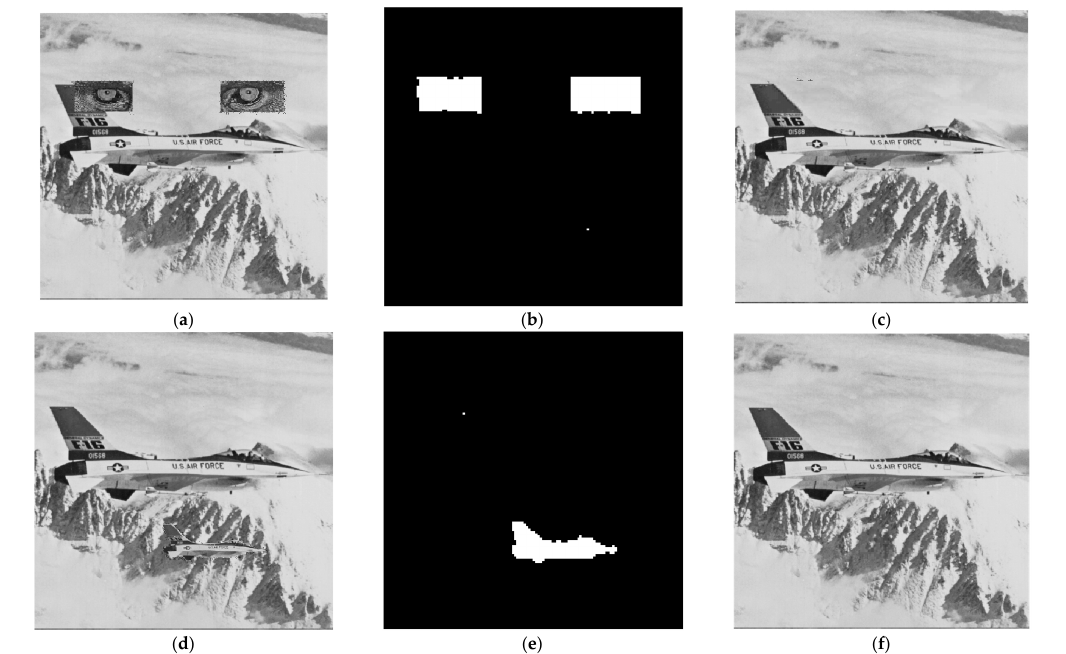
Figure 12. The visual performance for Barbara: ( a ) Cutting attack 1, ( b ) Detection of ( a ), ( c ) Recovery of ( a ), ( d ) Cutting attack 2, ( e ) Detection of ( d ), and ( f ) Recovery of ( d ). We further simulated two kinds of copy-paste attacks to measure the detection and recovery performance. The copy-paste attack copies the image blocks from one authenti- cated image and then inserts them into arbitrary positions in the watermarked image. Fig- ures 13 and 14 show the visual performance under copy-paste attacks for Airplane and Barbara, respectively. The tampering rates α are set to be 4.53% and 1.84% for copy-paste attack 1 and copy-paste attack 2, respectively. The simulation results show that the regions tampered with by the copy-paste attack can be sufficiently detected and recovered.